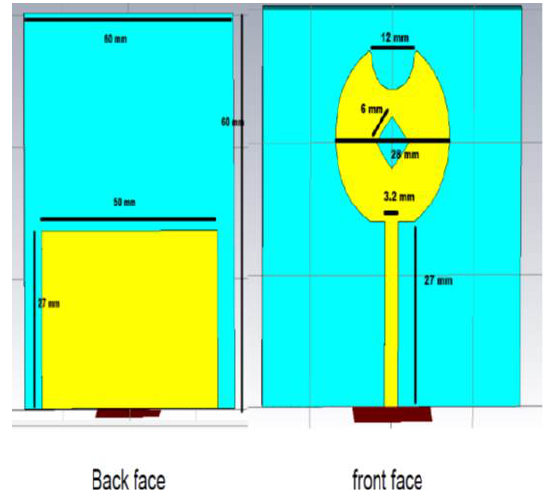
Figure 1: Particle size